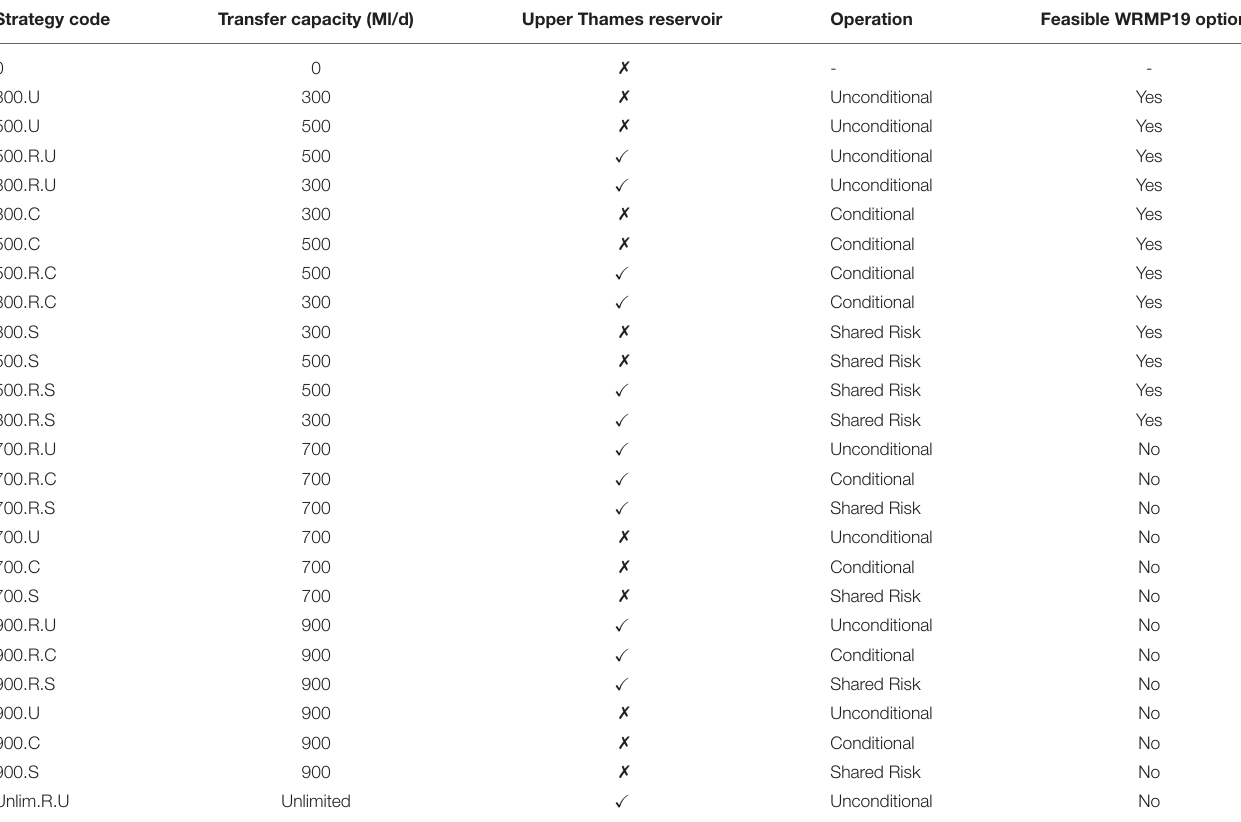
TABLE 1 | Transfer strategies to simulate under flow and demand scenarios. Strategy